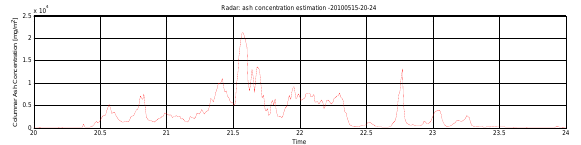
Figure 5: Columnar ash concentration derived from VACR al- gorithm by vertically integrating ash concentration derived from Fig. 4.